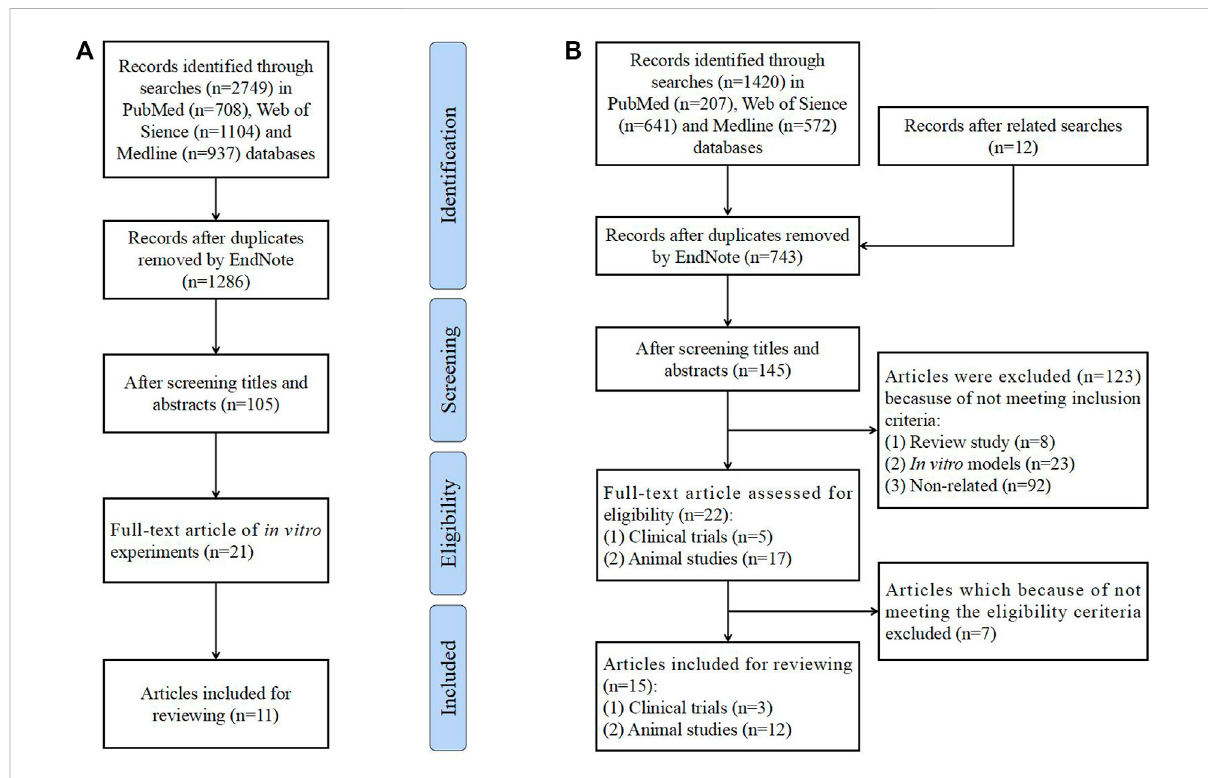
FIGURE 1 Flow diagram of the literature search and study selection process. (A) . Flow diagram of in vitro studies. (B) . Flow diagram of clinical trials and animal